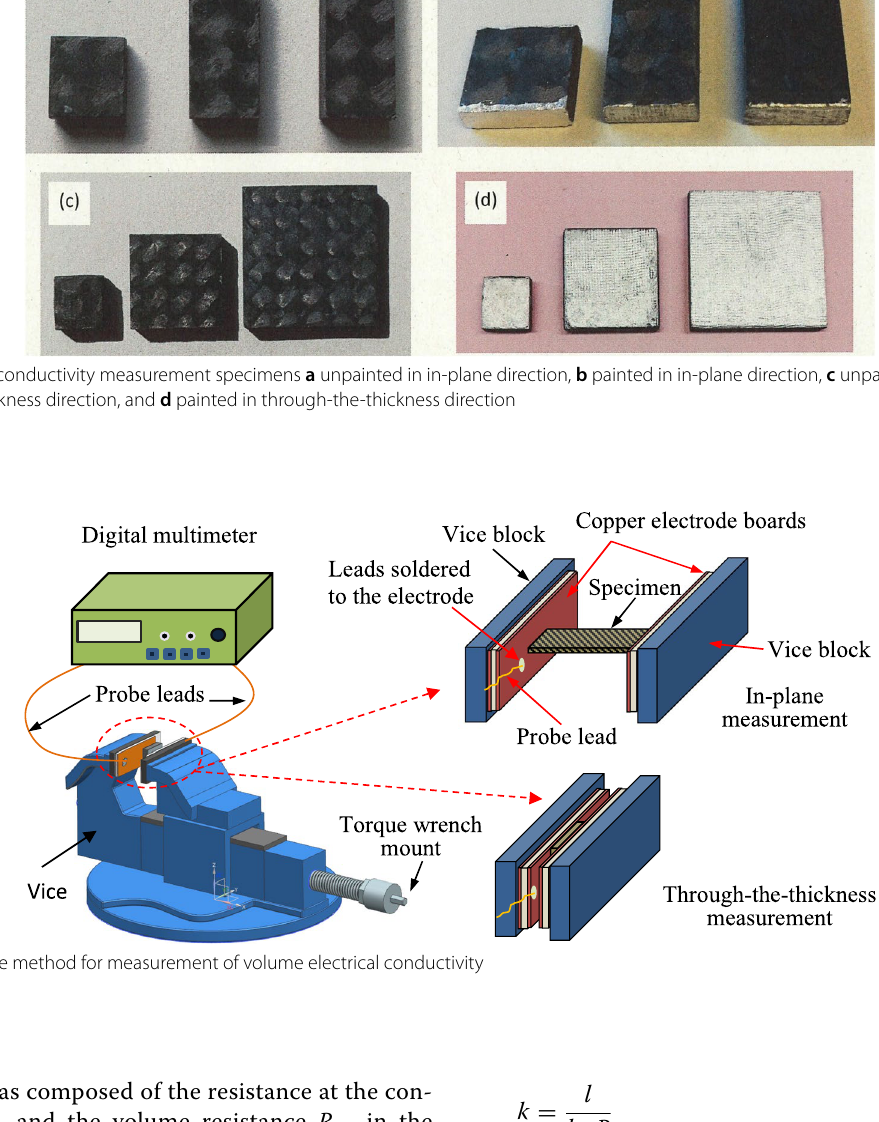
Experimental set‑up for electrical conductivity measurement A digital torque screwdriver Norbar 13850 with a range of 0.3 to 1.5 Nm and a lever arm radius of 10 mm was used to apply precise clamping torques with an accuracy of 6%, along with a Wera 7000A torque wrench with a ± range of 1 to 25 Nm. All the applied torques up to the